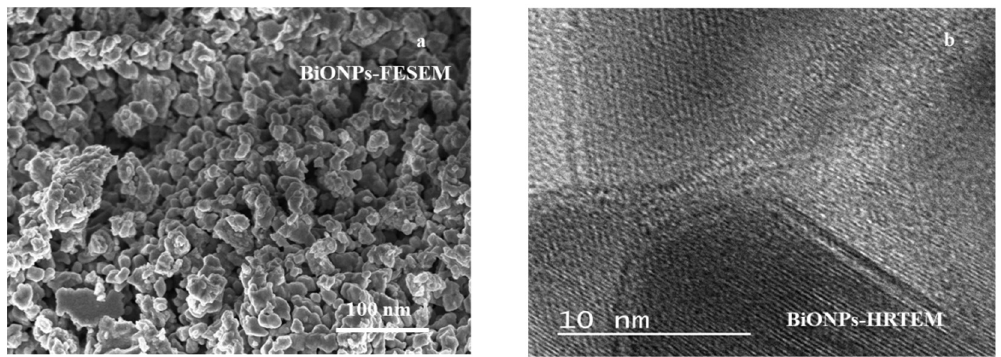
Figure 3. Microscopic analysis of BiONPs ( a ) morphology analysis through the FESEM technique and ( b ) crystal structure through TEM analysis.